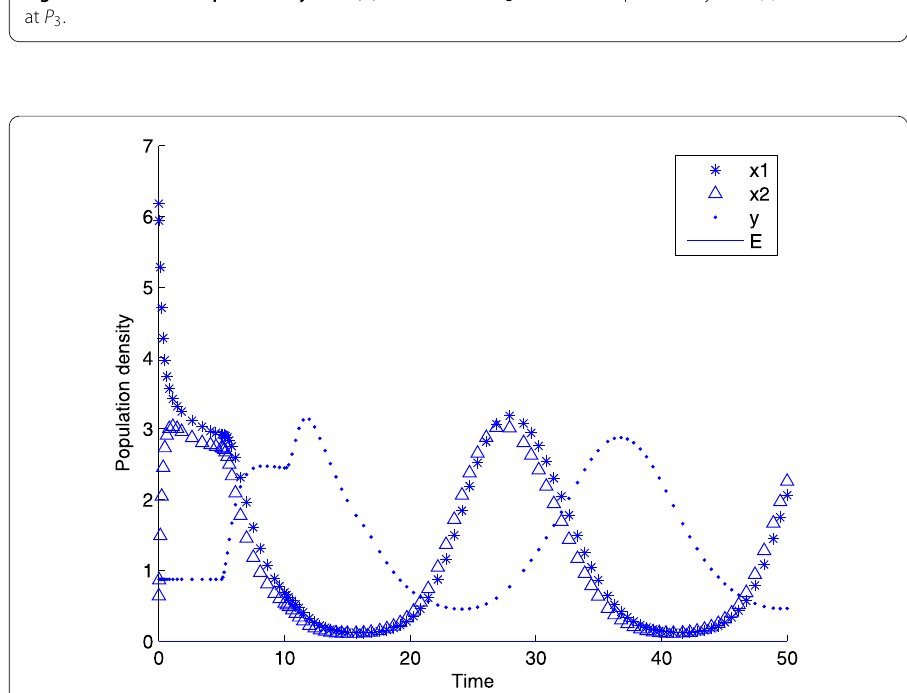
Figure 5 The state response of system (4) with τ = 5 at P 3 . The state response of system (4) with τ = 5 at P 3